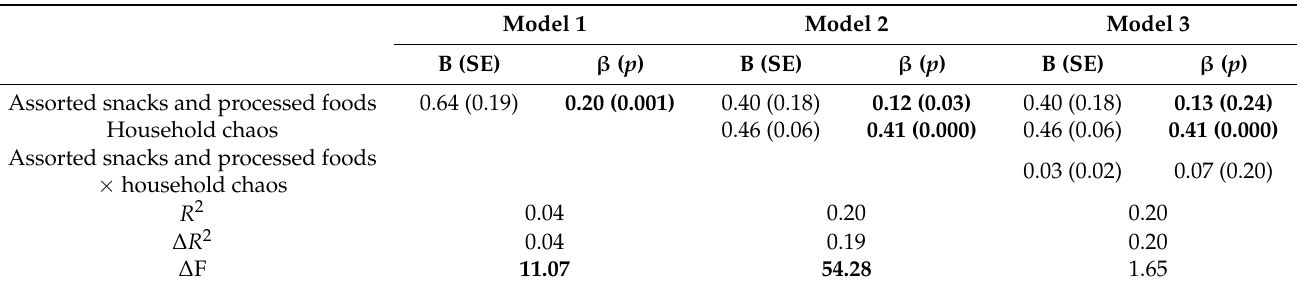
Table 4. Multiple Regression Analyzing Associations Between Assorted Snacks and Processed Foods, Household Chaos, and Inhibitory Self-Control Index (ISCI).